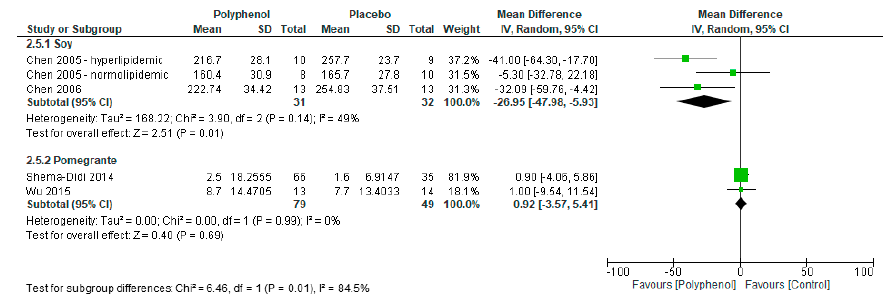
Figure 6. Forest plot of polyphenol-rich interventions on triglyceride levels.